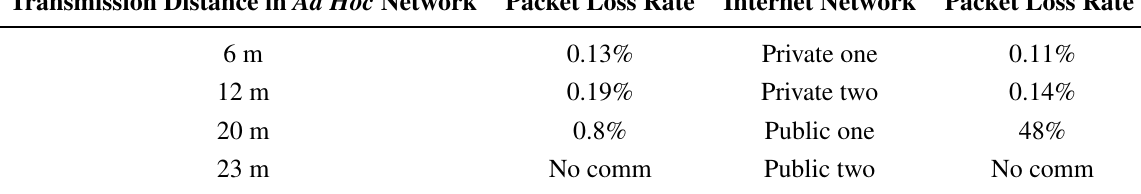
Table 5. Communication test (packet loss rate